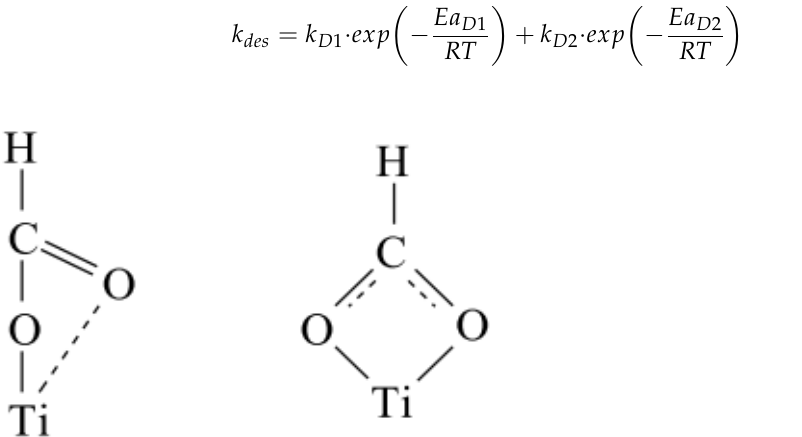
Figure 1. The formate ion bonded to the surface by a covalent bond (left), bidentate formate (right).